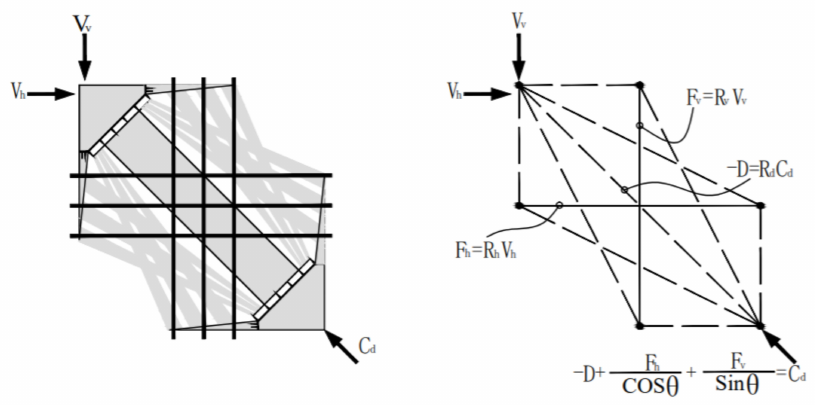
Figure 19. Working mechanism of the SSTM